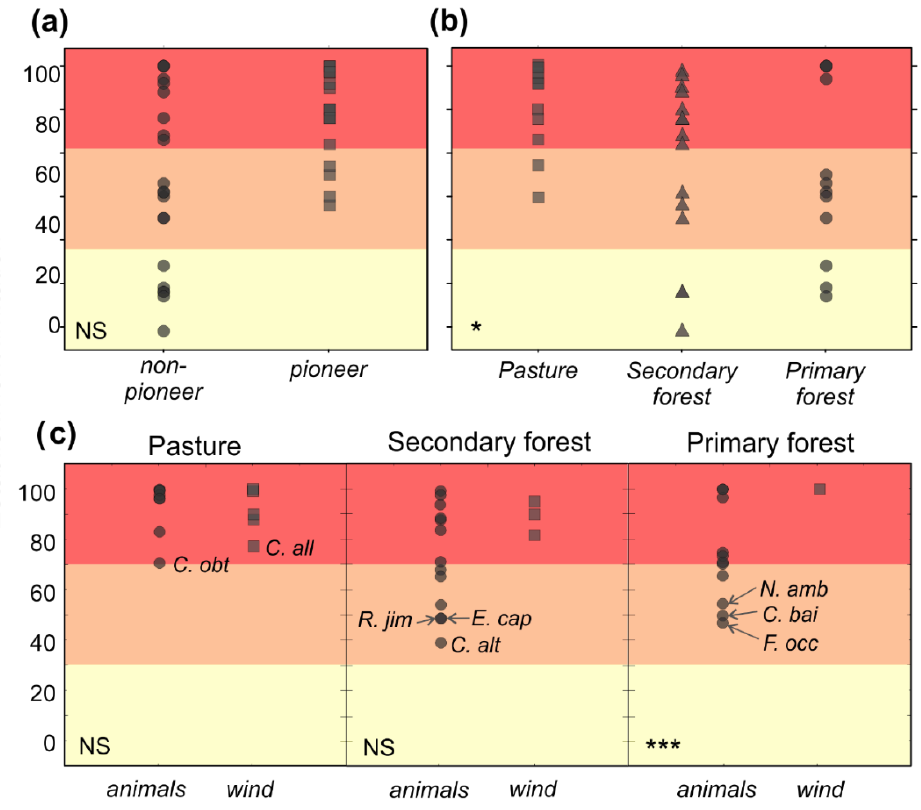
Figure 3. Plotted raw data of establishment limitation by: ( a ) life history; ( b ) habitat; and ( c ) habitat by dispersal mode among 33 tropical tree species. Different symbols (circles, squares or triangles) indicate different categories. The GLM model did not show significance for the interaction of habitat and life history, therefore the factors are shown independently marking the statistical significance between habitats and between life histories among all species. The interaction between habitat and dispersal mode was significant. Statistical significance between wind- and animal-dispersed species of each habitat is indicated with asterisks when significant (* p < 0.05, *** p < 0.001), M for marginal significance and NS for non-significant differences. Limitation from 0% to 33% was classified as low (yellow), from 34% to 66% as intermediate (orange) and from 67% to 100% as high (red). Over all habitats and species ( n = 33), seed size predicted establishment limitation ( R 2 = − 0.39; p